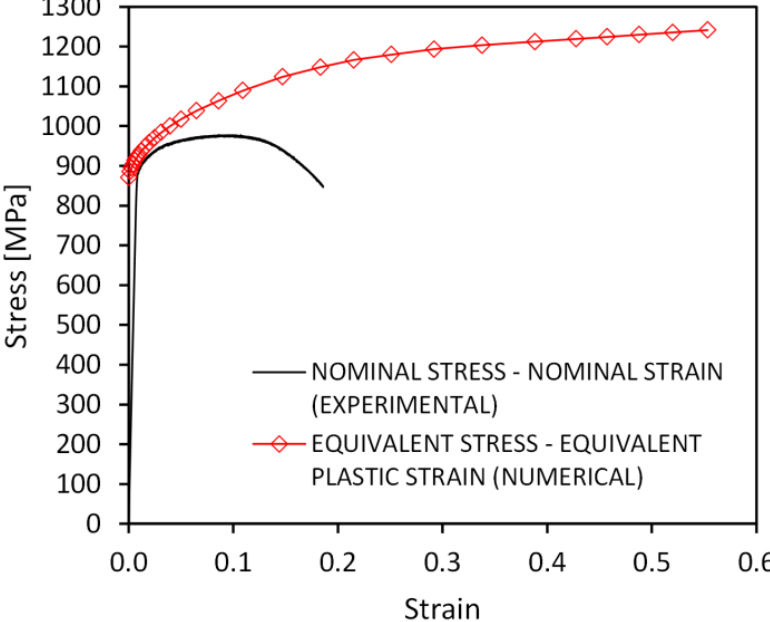
Figure 2. The true and nominal stress–strain curves for Ti–6Al–4V solid material obtained using 3D printing [26].